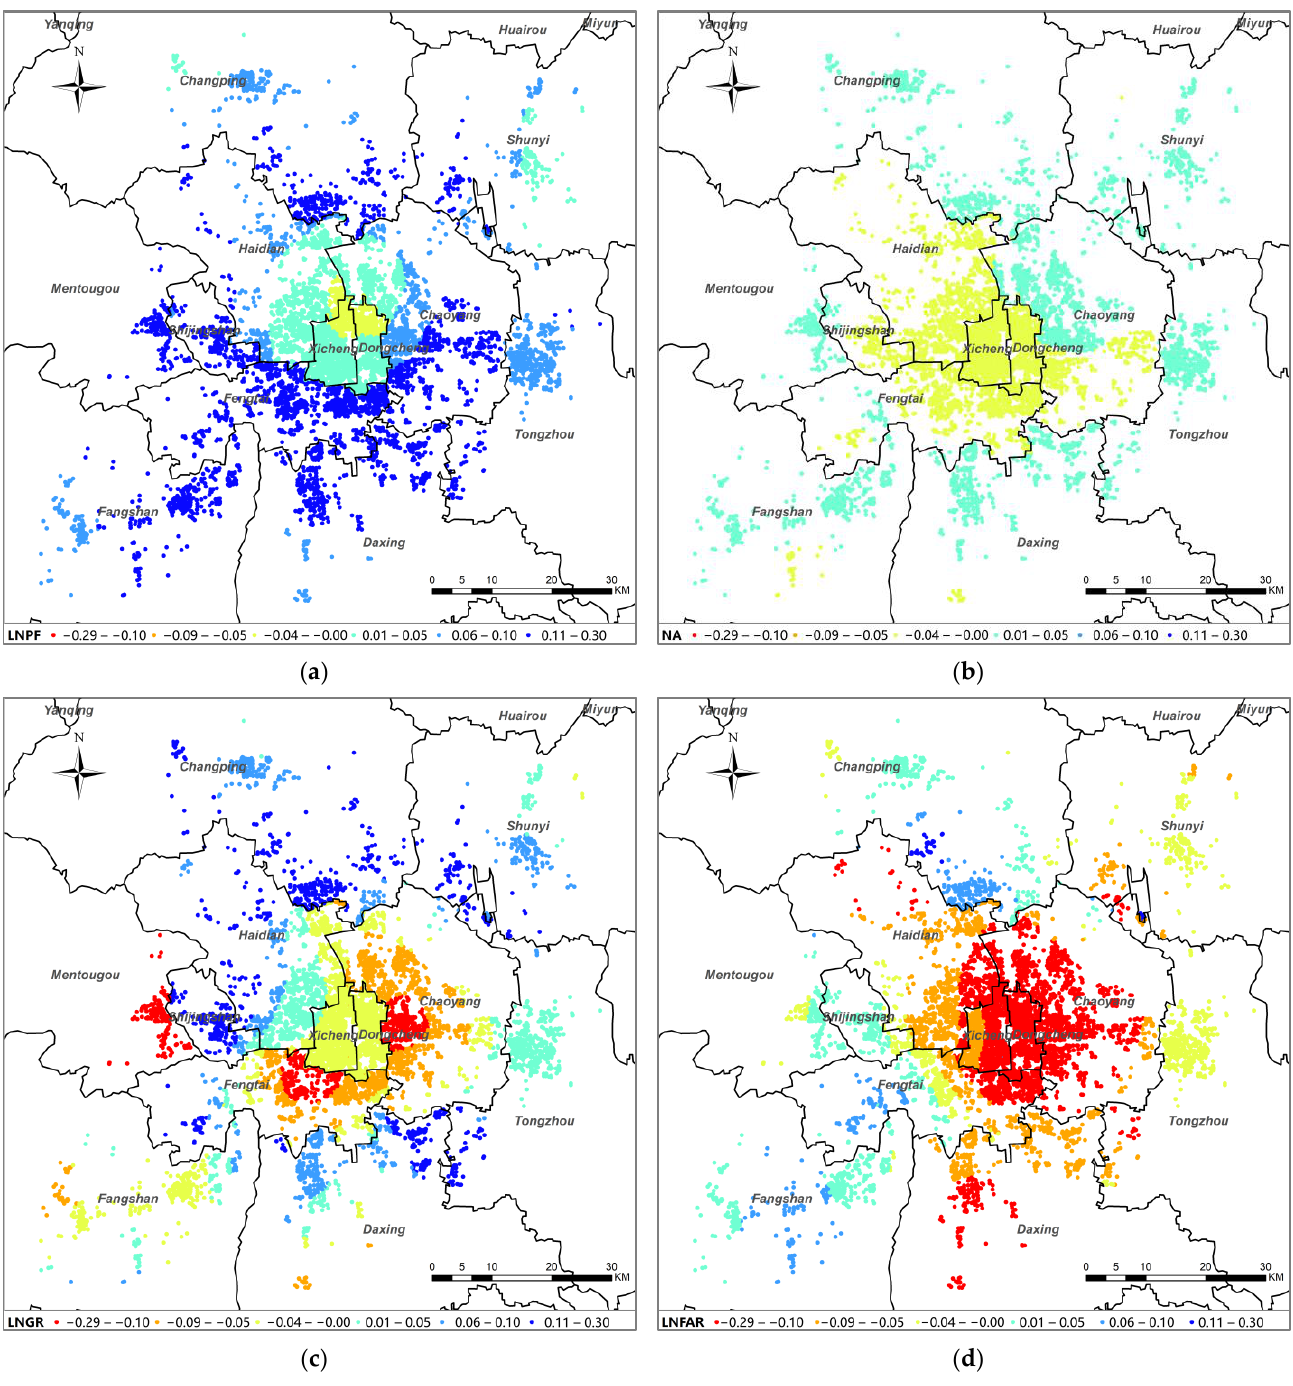
Figure 5. Structure covariates and temporal covariates map of the study area. ( a ) Log of the property fees (LNPF) map of the study area; ( b ) normalized building age (NA) map of the study area; ( c ) log of the FAR (LNFAR) map of the study area; and ( d ) log of the green ratio (LNGR) map of the study area.